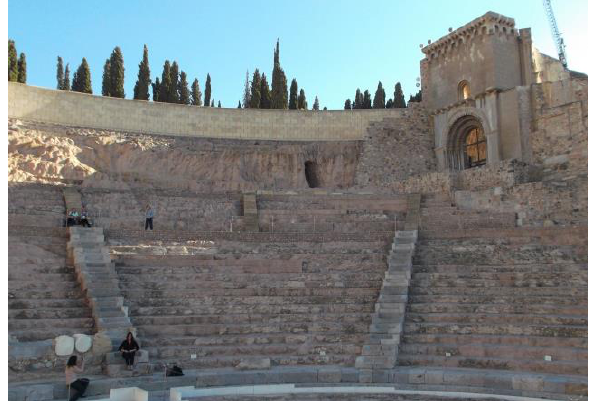
Figure 2. East facade of the Old Cathedral and cavea of the Roman Theater of